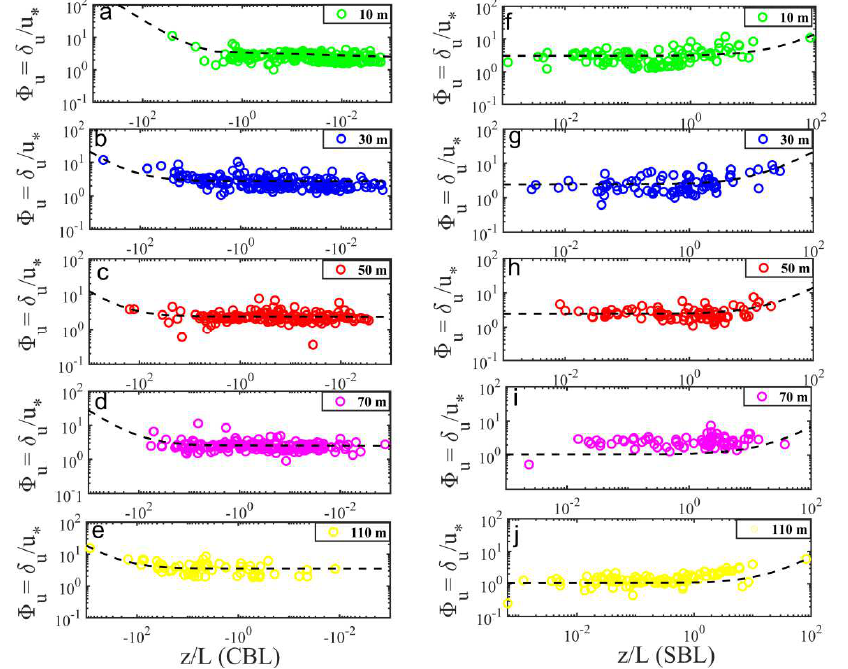
Figure 6. Plots of the normalized standard deviations of the longitudinal wind velocity components ( σ w / u ∗ ) in log–log scales versus the stability parameter ( z / L ) under unstable (or CBL, <0,) and stable (or UBL, ζ > 0) stratification conditions for the 10-min averaged onshore data collected during Typhoon Maria’s landfall (10–12 July 2018). The black dashed lines correspond to ϕ w ( ζ ) = 0.54 ( 10 − 4.24 ζ ) 1/3 for ζ < 0 and ϕ w ( ζ ) = ( 1 + 1 ζ ) 1/3 for ζ > 0 (Kaimal and Finnigan